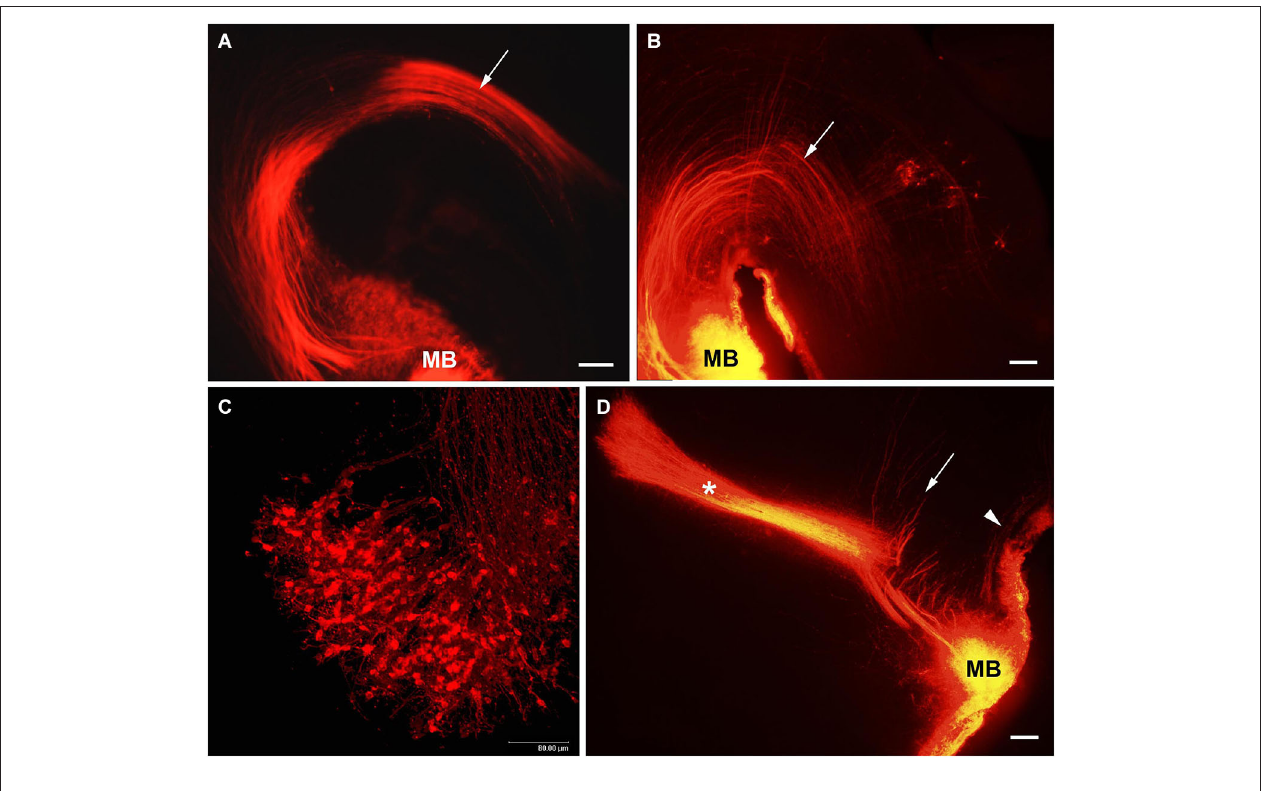
peduncle–arrowhead; mammillothalamic tract–asterisk. (C ) E16, high-magnification confocal image of the sagittal section of the mammillary body showing retrogradely labeled axons and neurons following DiI insertion in the tegmental region. Scale bars: (A,B,D) = 100 µ m, (C) = 80 µ